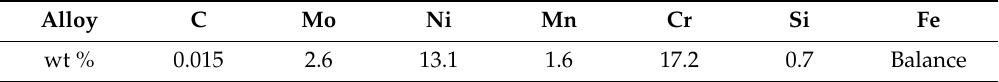
Table 3. Chemical composition of the metallic powder - Stainless Steel 316L.